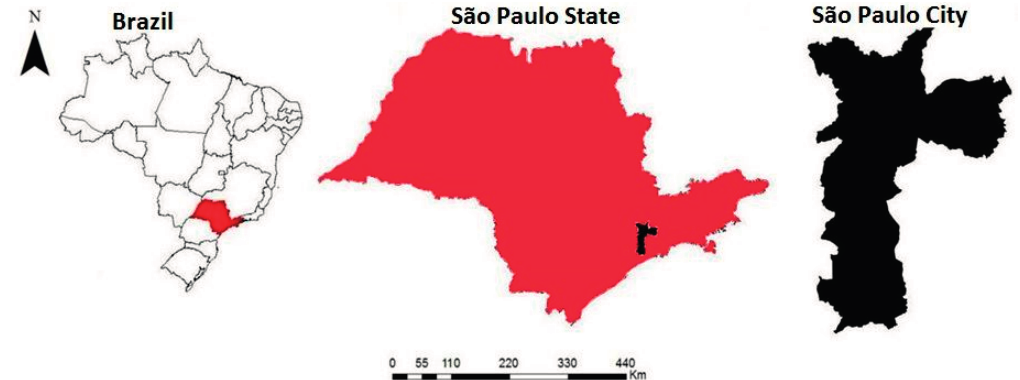
Figure 1. Study area: São Paulo. Source: